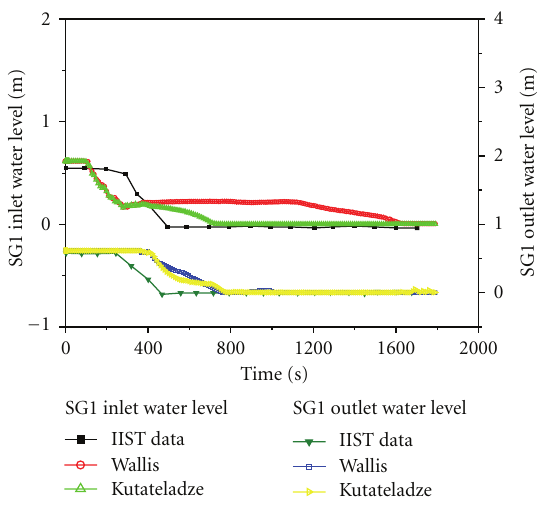
Figure 6: The comparison of SG1 inlet and outlet water level among Wallis form, Kutateladze form, and IIST data.